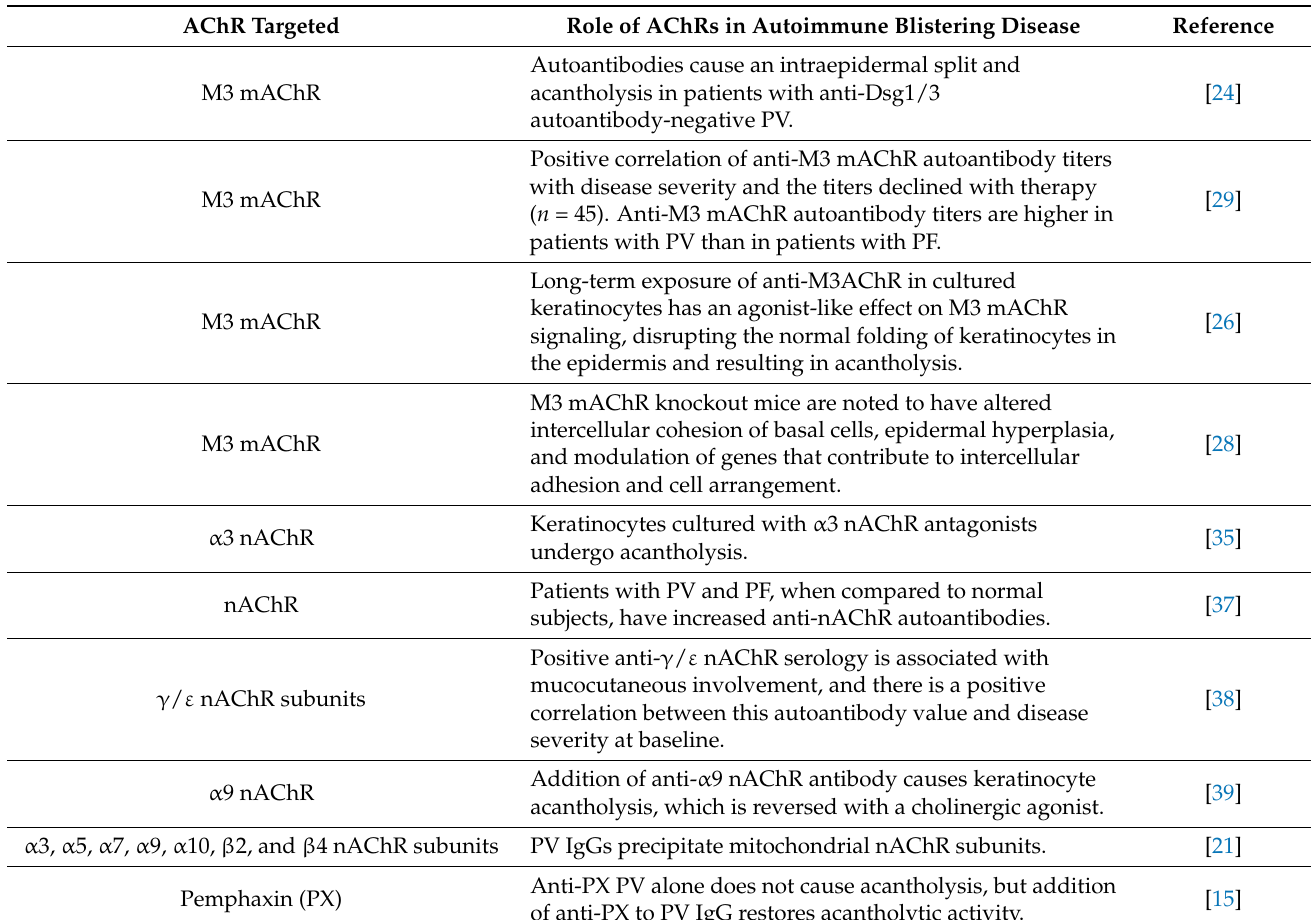
Table 1. Pathogenic anti-AChR antibodies implicated in